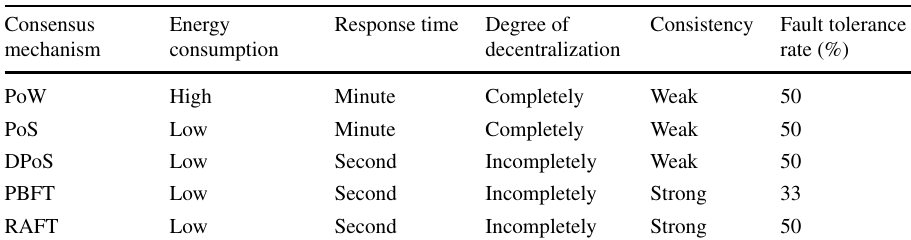
Table 1 Comparison of several consensus